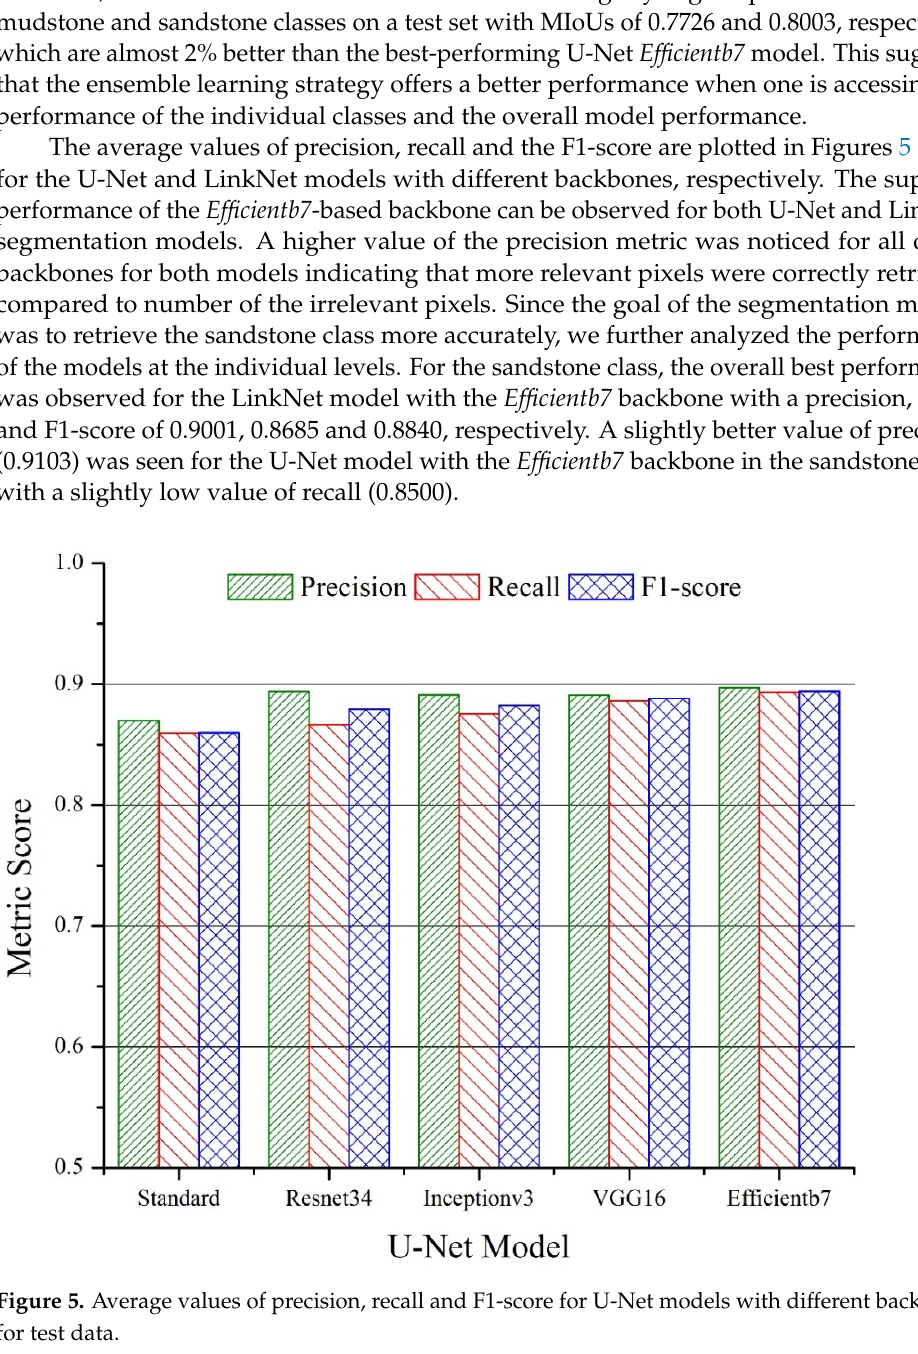
Figure 6. Average values of precision, recall and F1 ‐ score for LinkNet models with different back ‐ bones for test data. 3.2. U ‐ Net vs. LinkNet